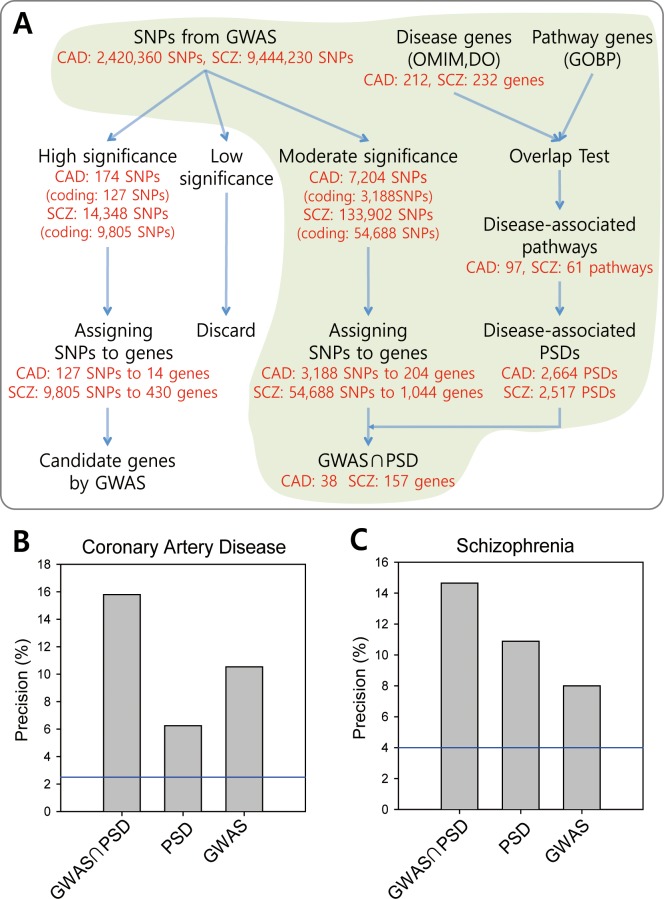
PSDs can predict disease genes.(A) A summary of candidate gene selection for coronary artery disease (CAD) and schizophrenia (SCZ) by integration of GWAS significance and PSD occurrence data. SNPs from GWASs were divided into three groups: (i) SNPs with high significance that indicate confident candidate genes; (ii) SNPs with low significance that are generally discarded; and (iii) SNPs with moderate significance that were considered for further selection in this study. Based on the overlap between disease genes and pathway genes, we converted domain-pathway associations into domain-disease associations to identify disease-associated PSDs. Candidate disease genes of the GWAS∩PSD set were selected based on the occurrence of disease-associated PSDs of the genes with moderate GWAS significance. (B) The precision of CAD gene predictions was assessed based on CADgeneDB annotations. The precision by random expectation (i.e., the number of disease genes / the number of all human genes) is indicated by the blue line (~2.5%). (C) The precision of SCZ predictions was assessed based on SZdatabase annotations. The precision by random expectation is indicated by the blue line (~4.1%).